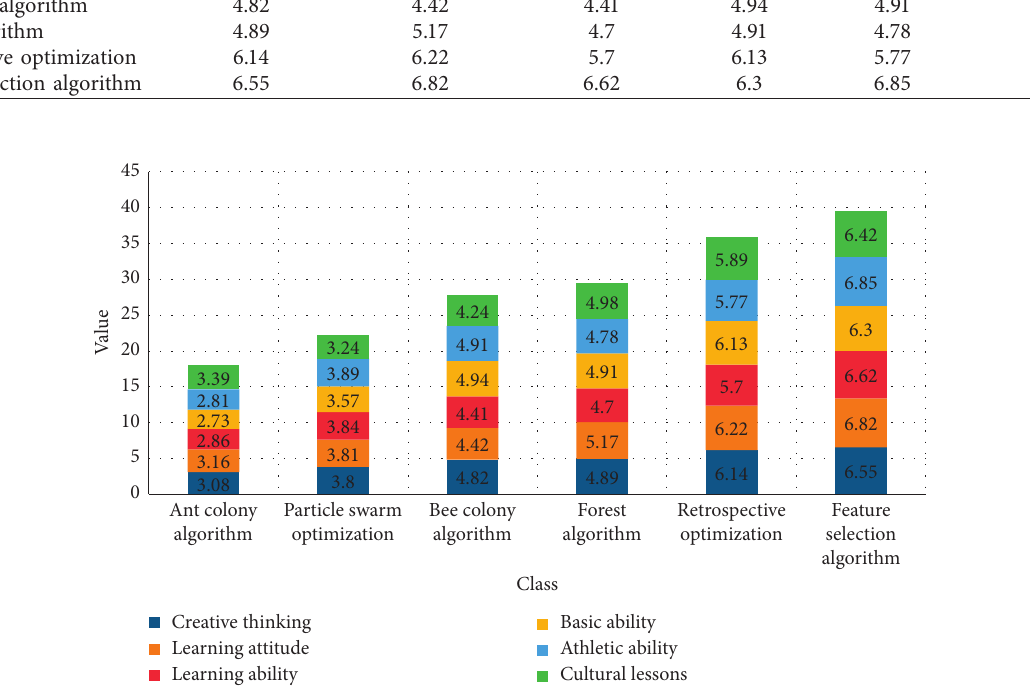
Figure 6: Female students after teaching. Table 5: Attitudes towards multimedia